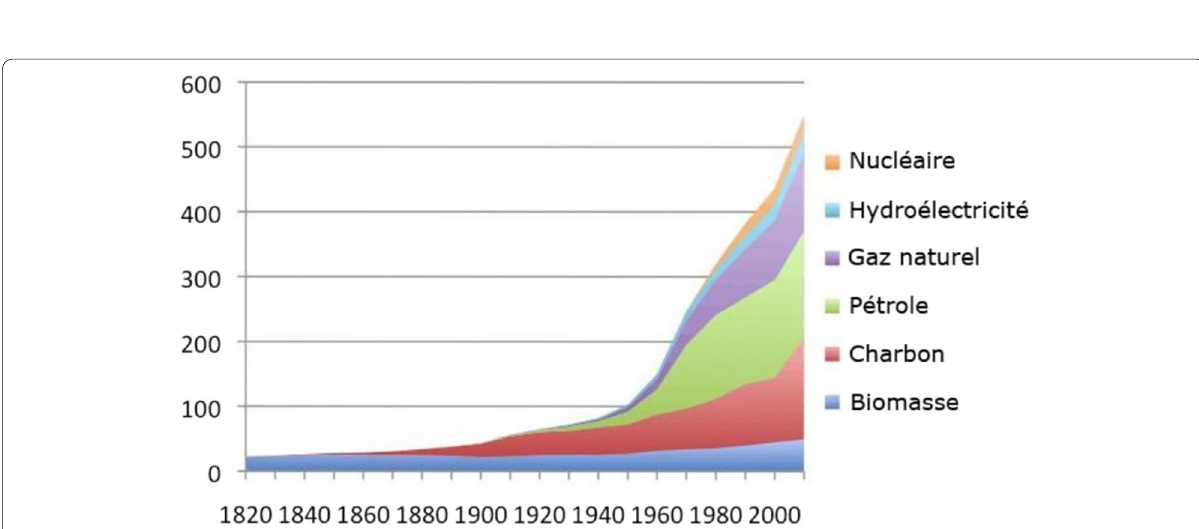
Fig. 7 Representative slide from student presentation on Energy and climate change. Source: http:// pure. iiasa. ac. at/ id/ eprint/ 10068/ used in accord with Creative Commons license. https:// creat iveco mmons. org/ licen ses/ by/3. 0/